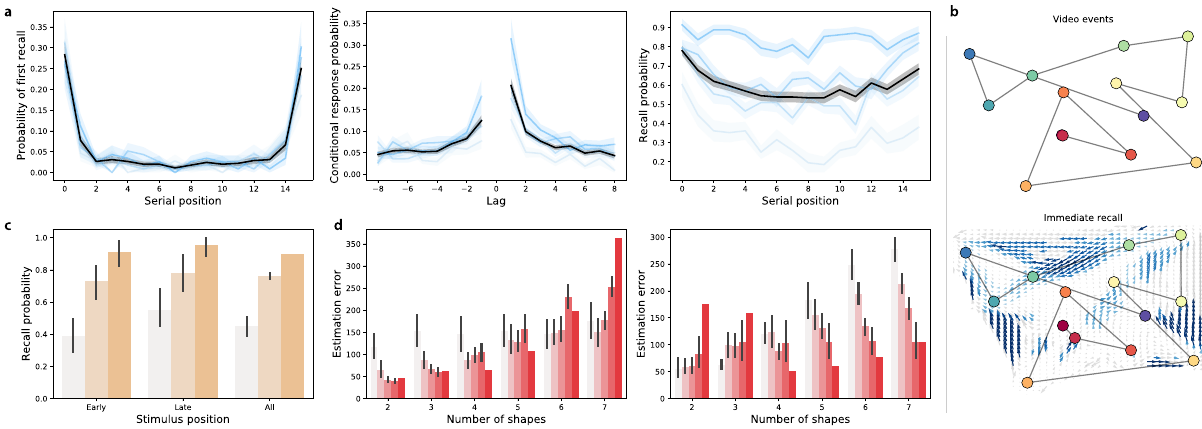
Figure 2. Immediate memory tests. ( a ) Free recall. Left: probability of recalling each word first as a function of its presentation position. Middle: probability of transitioning between successively recalling the word presented at position i , followed by word presented at position i + Lag . Right: probability of recalling each word as a function of its presentation position. See Fig. S2 for additional details. ( b ) Naturalistic recall. Top: 2D embedding of a 2.5-min video clip; each dot reflects a narrative event (red denotes early events and blue denotes later events). Bottom: 2D embedding of the averaged transcripts of participants’ recountings of the narrative (dots: same format as top panel). The arrows denote the average trajectory directions through the corresponding region of text embedding space, for any participants whose recountings passed through that region. Blue arrows denote statistically reliable agreement across participants ( p < 0.05 , corrected). See Fig. S3 for additional details. ( c ) Foreign language flashcards. Each bar denotes the average proportion of correctly recalled Gaelic- English word pairs from early (first 3), late (last 3), or all (i.e., all 10) study positions. See Fig. S4 for additional details. ( d ) Spatial learning. Average estimation error in shape locations as a function of the number of shapes. See Fig. S5 for additional details. All panels: error bars and error ribbons denote bootstrap-estimated 95% confidence intervals. Shading (saturation) denotes results for different subsets of participants assigned based on their task performance (Figs. S2, S3, S4, and S5 provide information about which performance metrics and values the shading reflects; in general more saturated colors denote participants who performed better on the given task.) In panel d , participants are grouped in two ways; in the left panel, participants are grouped